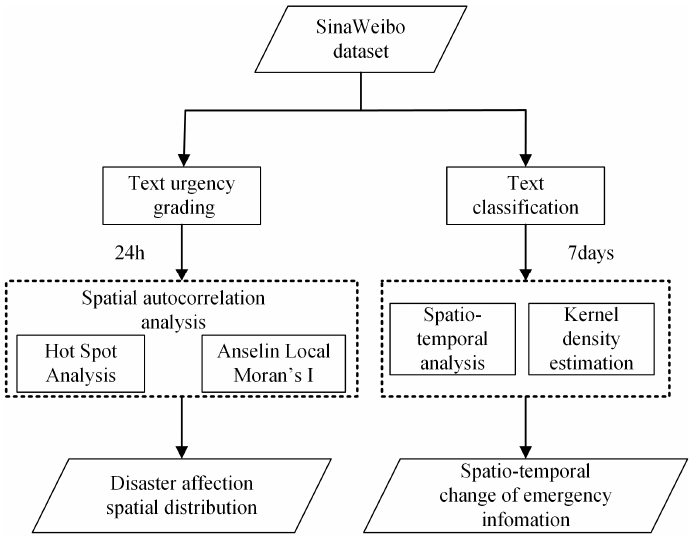
Figure 3. The process of research method.